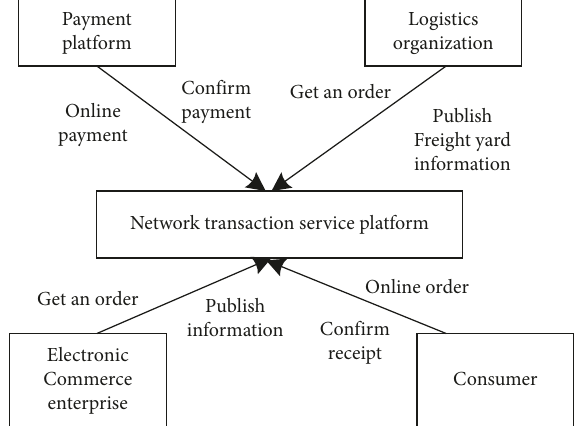
Figure 2: Cross-border e-commerce business